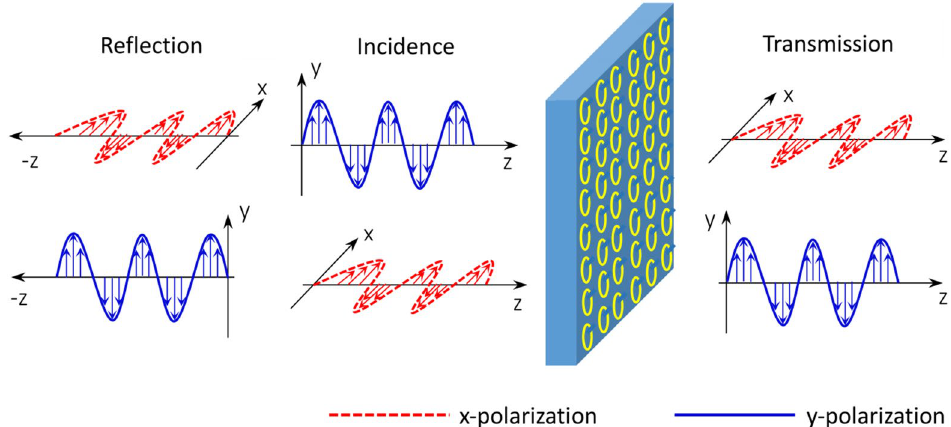
Figure 2. Operating principle diagram of the polarization conversion of the proposed MS. An x-polarized incident wave can be reflected and transmitted in the form of a y-polarized wave at the working frequencies, and a y-polarized wave can be reflected and transmitted as an x-polarized wave at the working frequencies. That is, the reflected wave and transmitted waves are converted into the orthogonal waves at the working frequencies. The red dotted line indicates the x-polarized wave, and the blue real line indicates the y-polarized